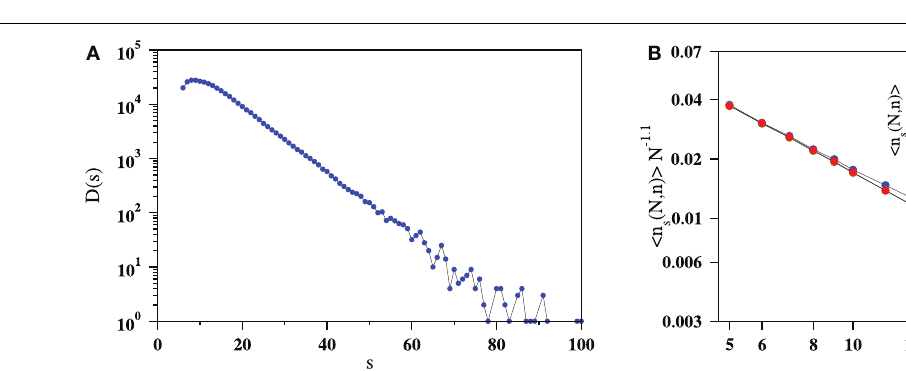
corresponding to a specific cluster of 16 agents have been shown. An arrow has been drawn from the agent i to the agent j if j is one of the n neighbors of i . There are a total of (16 × 5) / 2 = 40 distinct links and each link is directed in both directions. It may also be noted that whole set of links are restricted to the nodes of the cluster only.